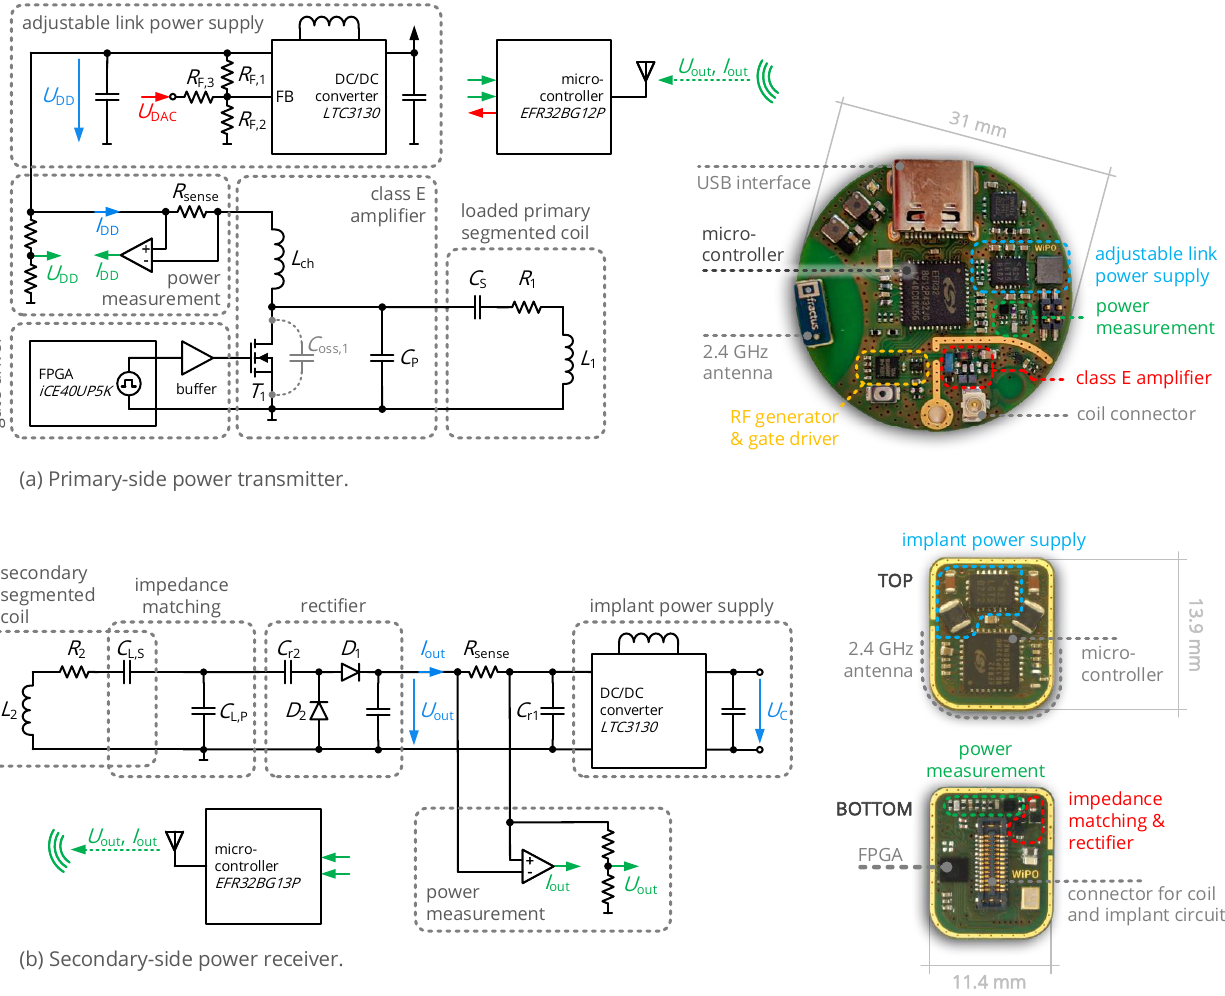
Figure 10. Schematics and PCB-level implementations of the power-conditioning